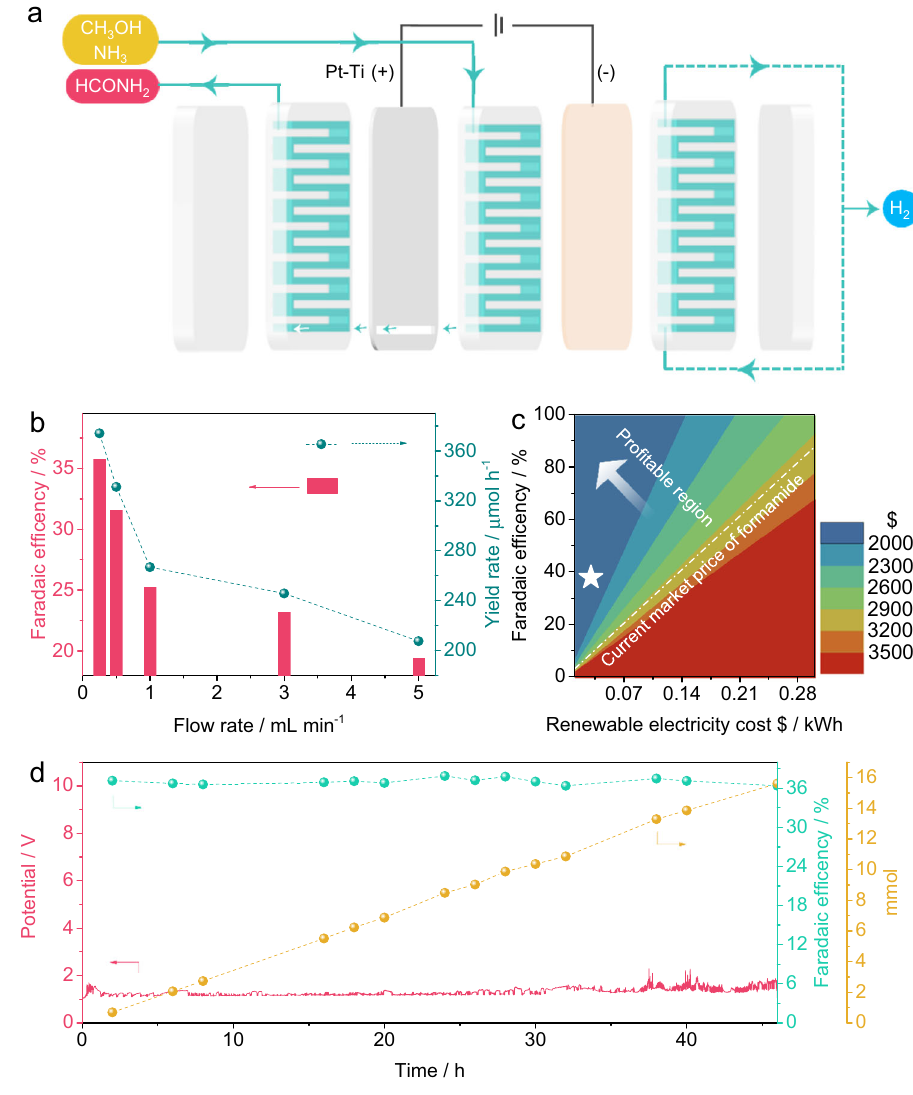
Fig. 4 | The continuous electrosynthesis of formamide in a fl ow cell. a The schemeof fl owcell; b Theoptimizationof fl owrateforformamideelectrosynthesis; c TEA of the levelized cost offormamide electrosynthesis asa functionofFaradaic